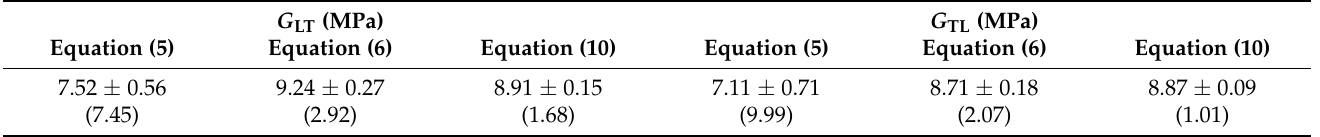
Table 4. G LT and G TL values calculated using Equations (5), (6), and (10). G LT (MPa)